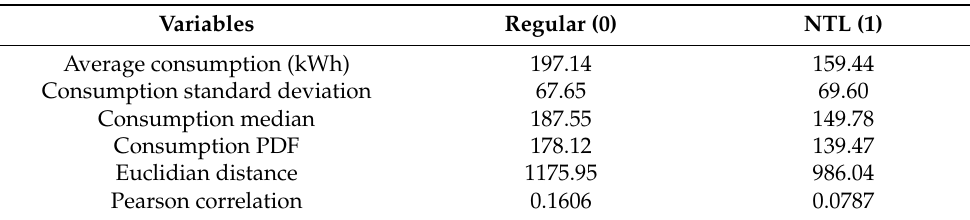
Table 9. Description of CUs Consumption Labeled as NTL and